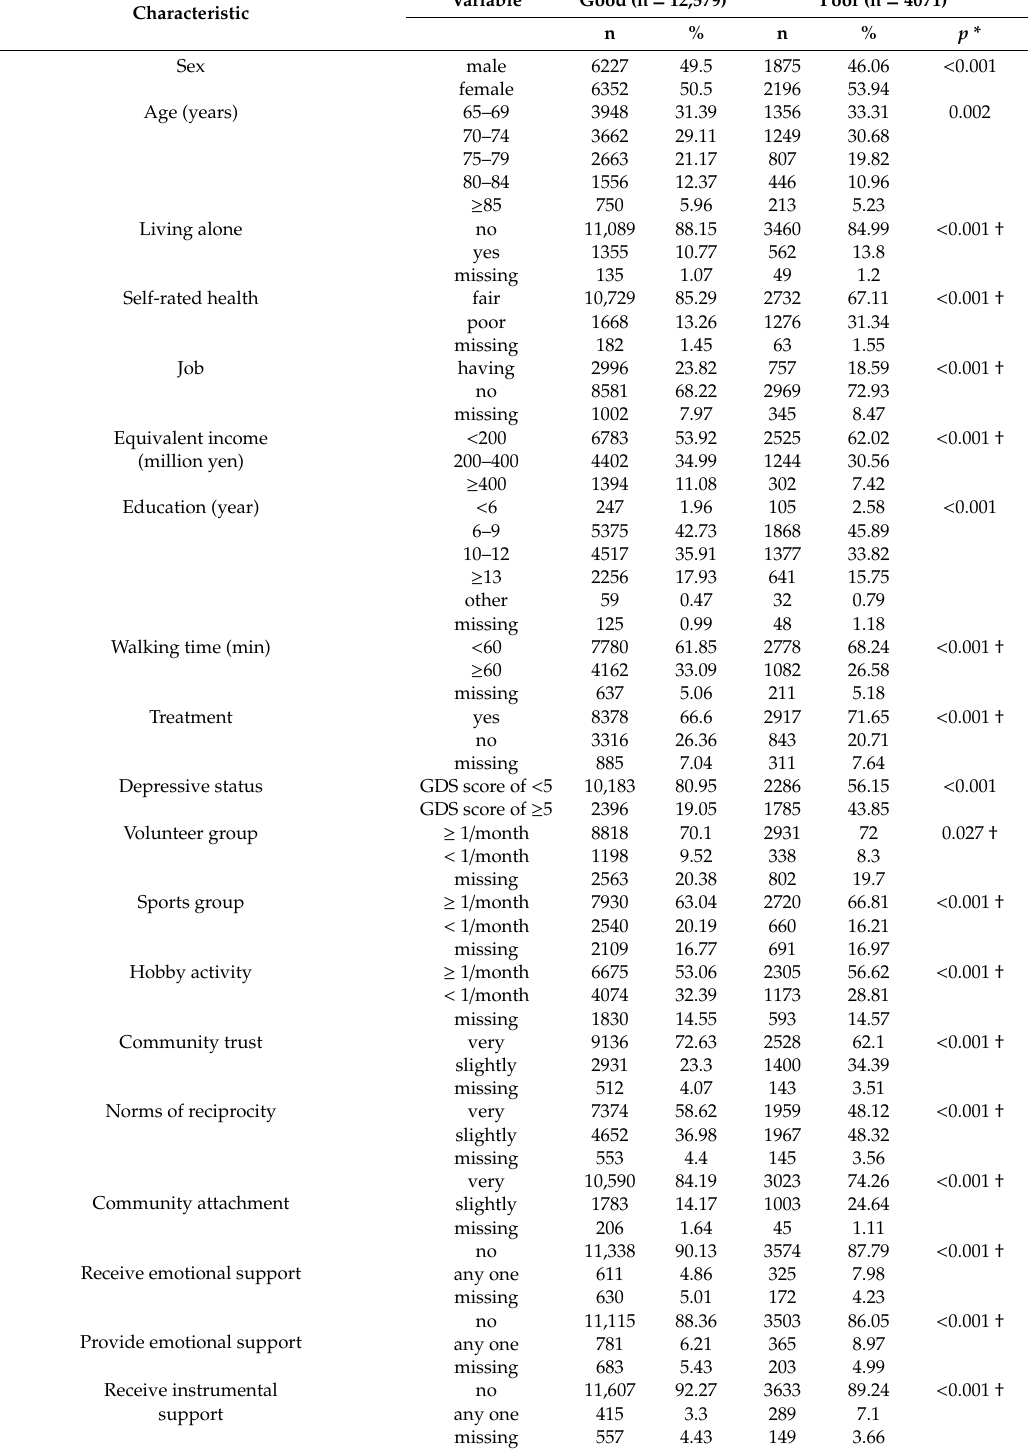
Table 1. Characteristics of the study participants divided by sleep quality (good or